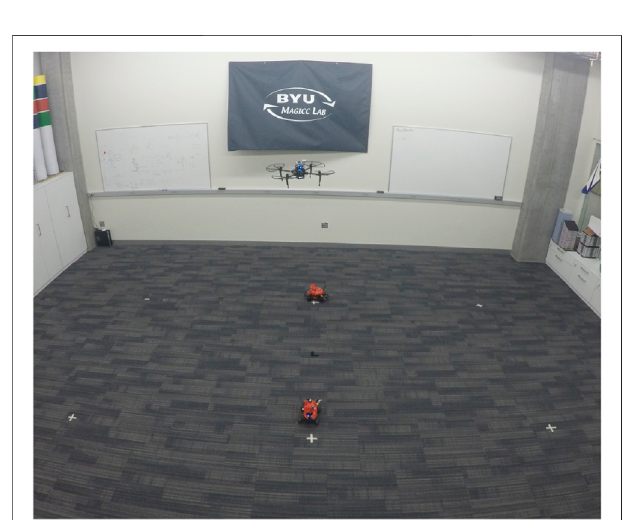
FIGURE 13 | A photo of our hardware in action. The quadcopter is hovering above the second target while it is still unaware of the location of the fi rsttarget.ThetargetsaresmallredRCcarsrunningdubinspathbetweenthe six markers on the ground.